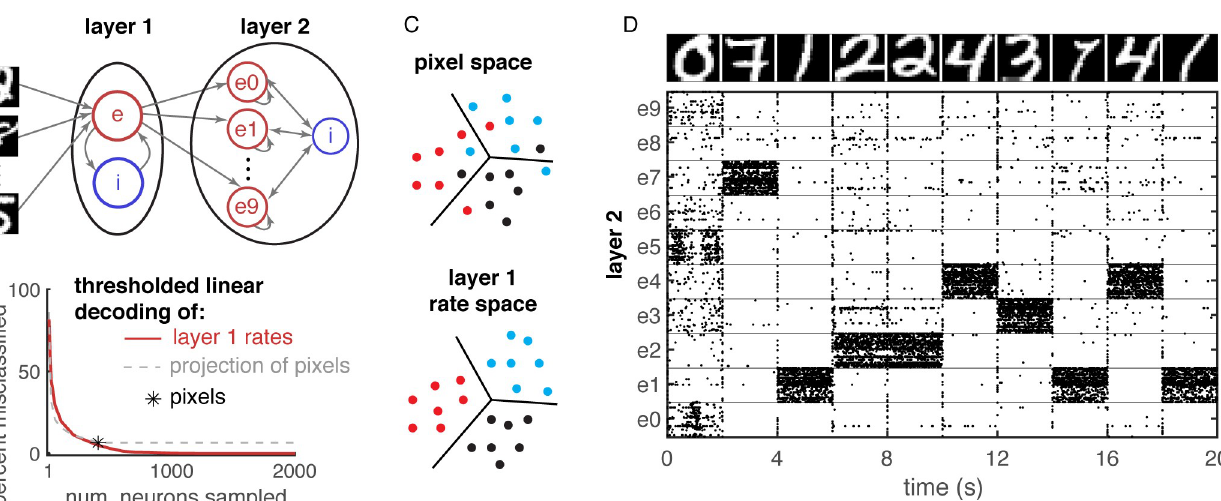
PLOS Computational Biology | https://doi.org/10.1371/journal.pcbi.1008192 September 18,